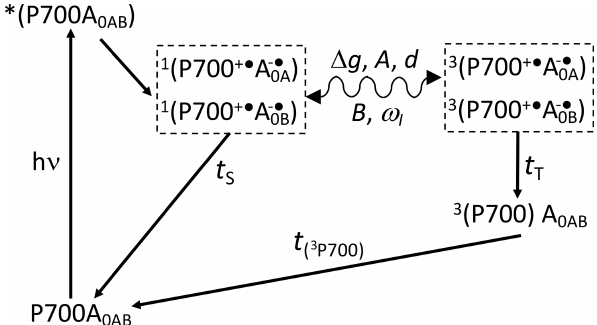
Scheme 1. Reaction cycle in PSI, with reduced F X acceptor and electron transfer, over both branches of cofactors A and B. After the absorption of a photon, electron transfer occurs from the P700 donor to the primary acceptors A 0 . Upon chemical prereduction of F X , the electron transfer becomes cyclic. Due to spin conservation, the spin-correlated radical pair (SCRP) are formed in a pure sin- glet state. The SCRP in its singlet state can either recombine to the diamagnetic ground state or undergo coherent singlet–triplet inter- conversion to its electronic triplet state. This interconversion relies on the difference in the g values of the two electrons, (cid:49)g , and the hyperfine interaction with magnetic nuclei. According to the radical pair mechanism (RPM), this influence of the nuclei on the radical pair dynamics leads to spin sorting and, hence, to enrichment of nu- clear spin states in the two decay channels. In frozen samples, three- spin mixing (TSM) produces nuclear hyperpolarization based on the secular part of the hyperfine interaction, A , the coupling between the two electrons, d , the pseudosecular hyperfine coupling, B , and the nuclear Zeeman frequency, ω I . Furthermore, as caused by the different kinetics of the two decay channels ( T S vs. T T ), the dif- ferential decay (DD) mechanism for nuclear spin hyperpolarization occurs. From the triplet state of the SCRP, a molecular donor triplet state is formed, which decays with a triplet lifetime, T ( 3 P700), of ∼ 3µs (Polm and Brettel, 1998), making the occurrence of the dif- ferential relaxation (DR) mechanism